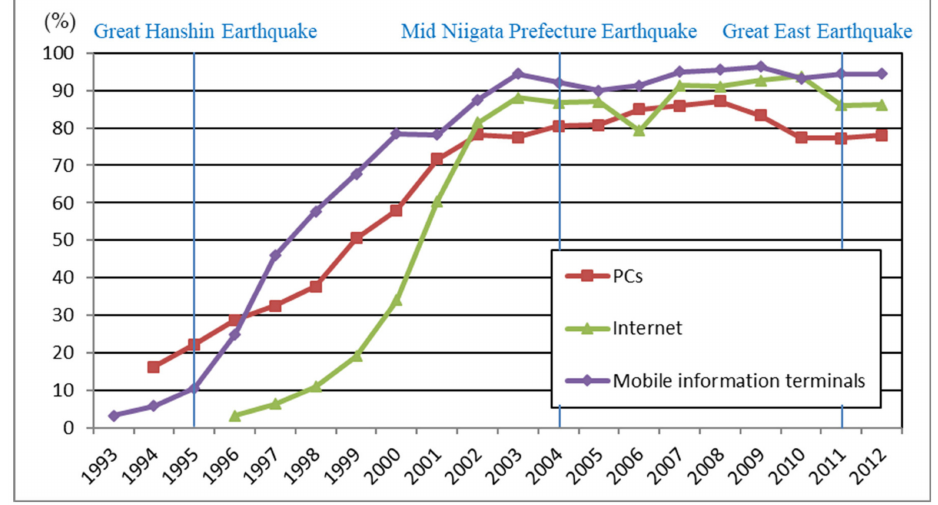
Figure 1. Penetration rate of the PCs, internet, and mobile phones (1993–2012). Note—created based on the Consumer Behavior Forecasting Survey 2014